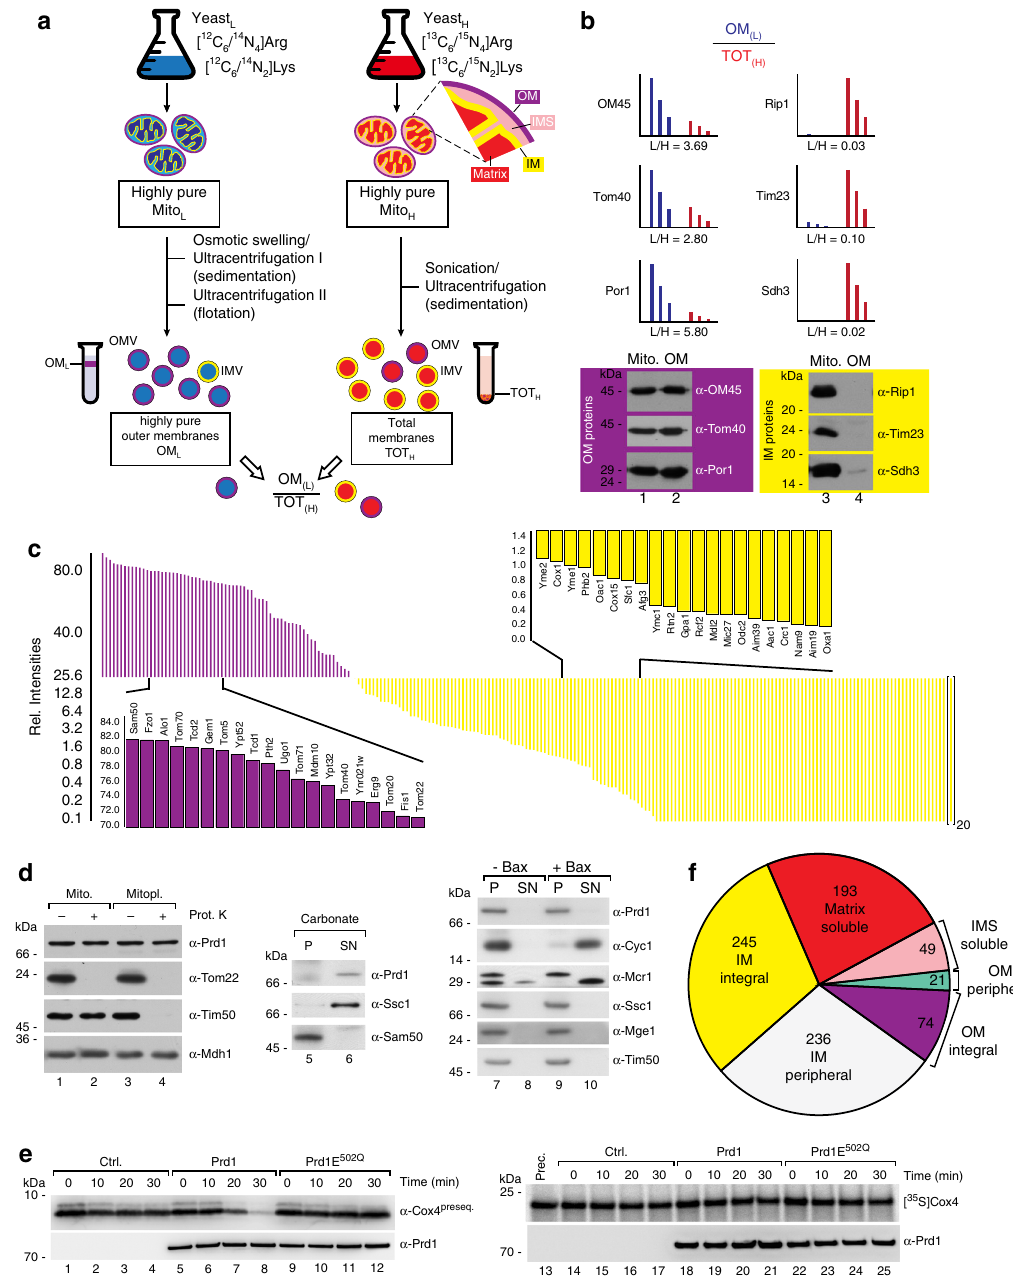
Fig. 4 Integrating the landscape of submitochondrial protein distribution. a Experimental design for global allocation of integral outer and inner membrane proteins. Highly puri fi ed mitochondria from a light yeast culture were used for isolation of highly pure outer membrane fractions 31 (OM L ). Total membrane fractions were generated from mitochondria of a heavy labeled yeast culture (TOT H ). Both samples were mixed and the ratios OM L /TOT H measured by LC-MS. b OM L /TOT H ratios of selected integral outer and inner membrane proteins and validation by immunoblotting. c Array of determined OM L /TOT H ratios reveals distribution of integral mitochondrial outer and inner membrane proteins (shown as relative intensities for proteins in the OM fraction). d Sublocalization of Prd1 to the mitochondrial matrix. e Cell-free translated Prd1 and Prd1 E502Q protein was incubated with Cox4 presequence peptide (Cox4 preseq. ; left panels) or radiolabeled Cox4 precursor protein ( right panels) for indicated time. Ctrl ., control (mock translation). f Complete overview of the landscape of submitochondrial protein distribution. Allocation of the mitochondrial proteome to the various subcompartements deciphered in this study range between 1 and 10 are present in additional cellular (Supplementary Data 3), that has been annotated as a cytoplasmic subfractions containing cytosol (S100) or microsomes (P100; aspartyl aminopeptidase 8, 28 and tested their localization in different Fig. 3b, lanes 7 – 12). Proteins with ratios > 10 can be traced to cellular compartments by immunoblotting. While proteins with mitochondria only after long exposure of the immunoblot as Yeast/Mito ratios < 1 were detected only in the mitochondrial shown, e.g., for the eclipsed distributed superoxid dismutase Sod1 fraction (shown for the resident mitochondrial proteins, Sod2, (Fig. 3b, lanes 13 – 14). Mdh1 and Tom22; Fig. 3b, lanes 4 – 5) proteins with ratios that NATURE COMMUNICATIONS | 8: